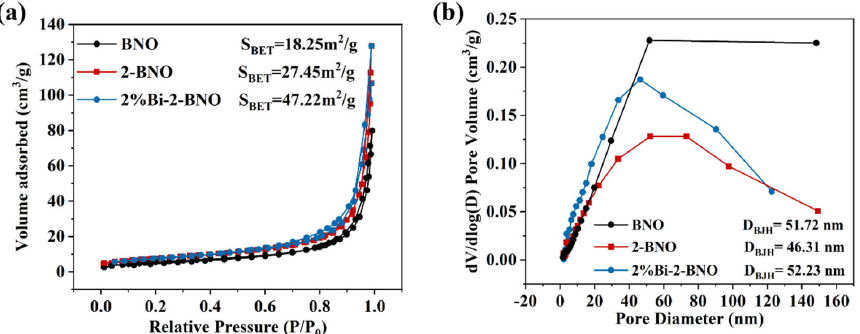
Figure 7. ( a ) N 2 adsorption–desorption isotherms for the photocatalytic samples, as well as ( b ) their pore size distribution curves.